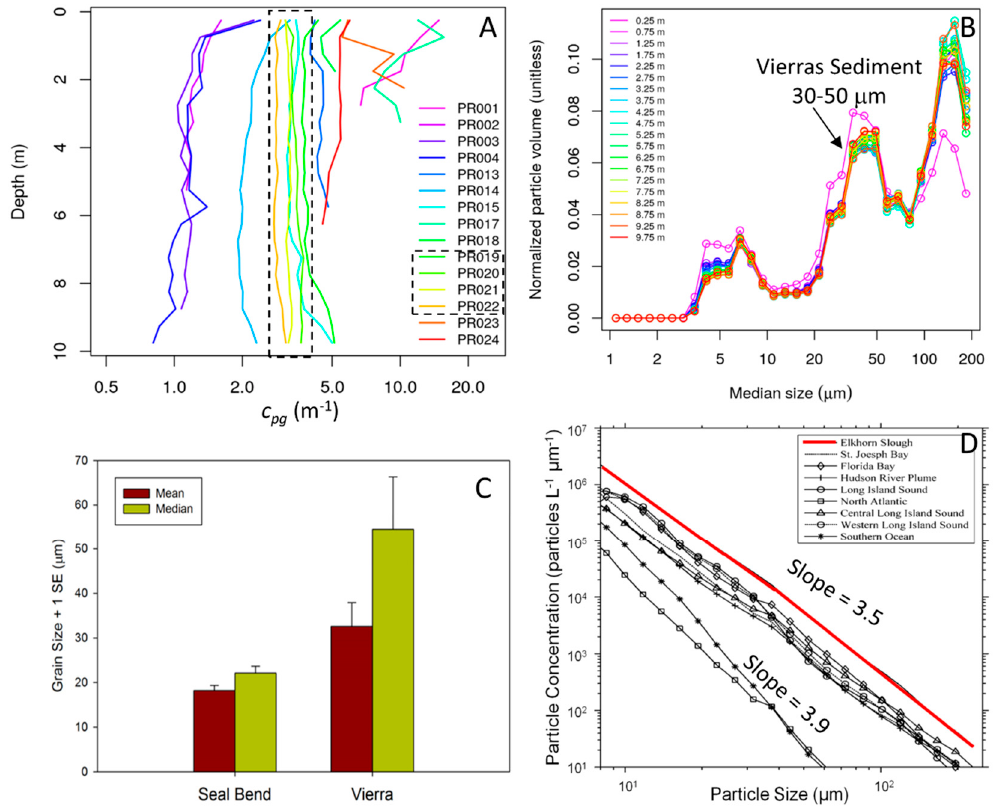
Figure 6. The optical properties in Elkhorn Slough are dominated by highly scattering particulate matter. ( A ) Measurements of light attenuation by particles and colored dissolved matter (cpg) from the LISST-100X show that the water column was well mixed during the stations coincident with the overflights (black box). ( B ) The particulate volumetric size distribution from the stations outlined in panel A reveals three predominant particle populations from 5–10 µ m, 30–50 µ m, and 120–150 µ m. ( C ) The mean sediment particle sizes measured within two eelgrass beds reveals larger particles at the Vierra bed consistent with size of suspended particles measured with the LISST data from Panel B. Adapted from [45]. ( D ) A global comparison of particle size distributions shows the high amount of particulates and flatter Jungian slope in Elkhorn Slough compared to other sites. Adapted from [24]. Table 1. Retrieval of different seagrass beds in Elkhorn Slough from Google Earth time series.